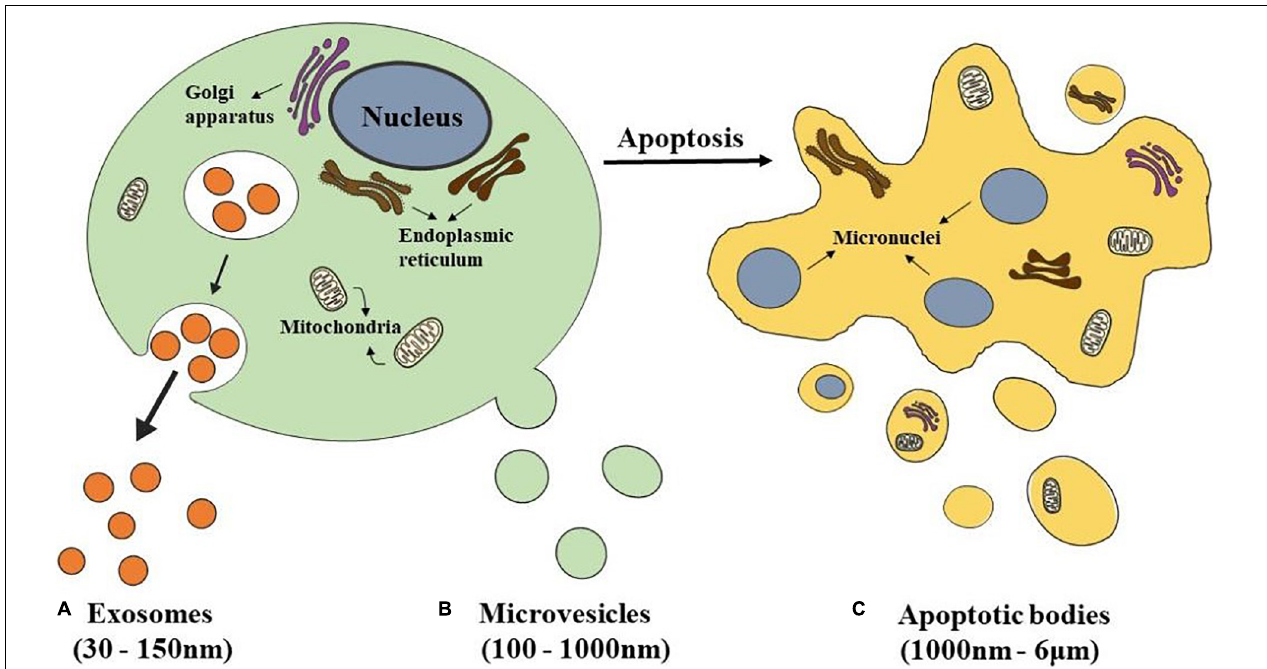
FIGURE 1 | Schematics representation of different types of EVs. (A) Exosomes are released from eukaryotic cells by fusion of internal multivesicular compartments (MVB). (B) Microvesicles are formed by direct budding from the plasma membrane. (C) Apoptotic bodies are released from apoptotic